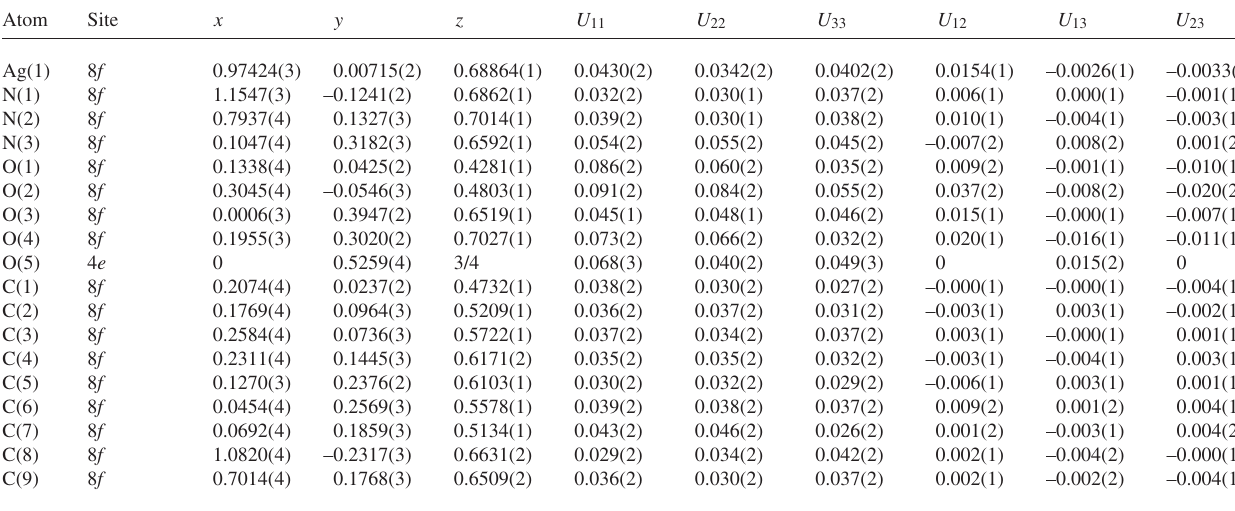
Table 3. Atomic coordinates and displacement parameters (in Å 2 ) .